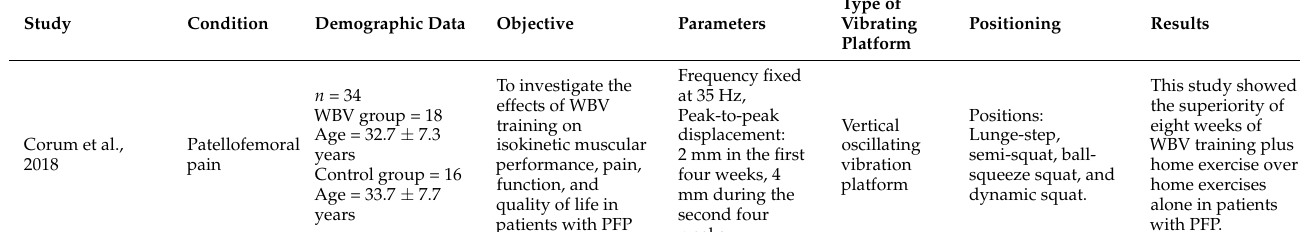
Table 4. Different populations submitted to WBV exercise, with symptoms also observed in the COVID-19 patients:pain.